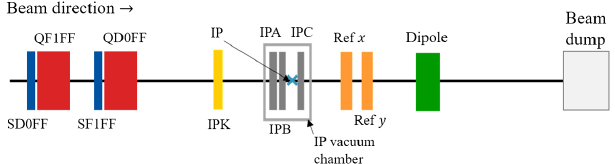
FIG. 3. Schematic of the electric and magnetic field lines of (a) the TM010 mode for a circular cylindrical cavity BPM and (b) the TM210 mode (or x -dipole mode) for a rectangular cylindrical cavity BPM. The waveguides which couple to the TM210 mode are shown. There are also corresponding wave- guides which couple to the y -dipole TM120